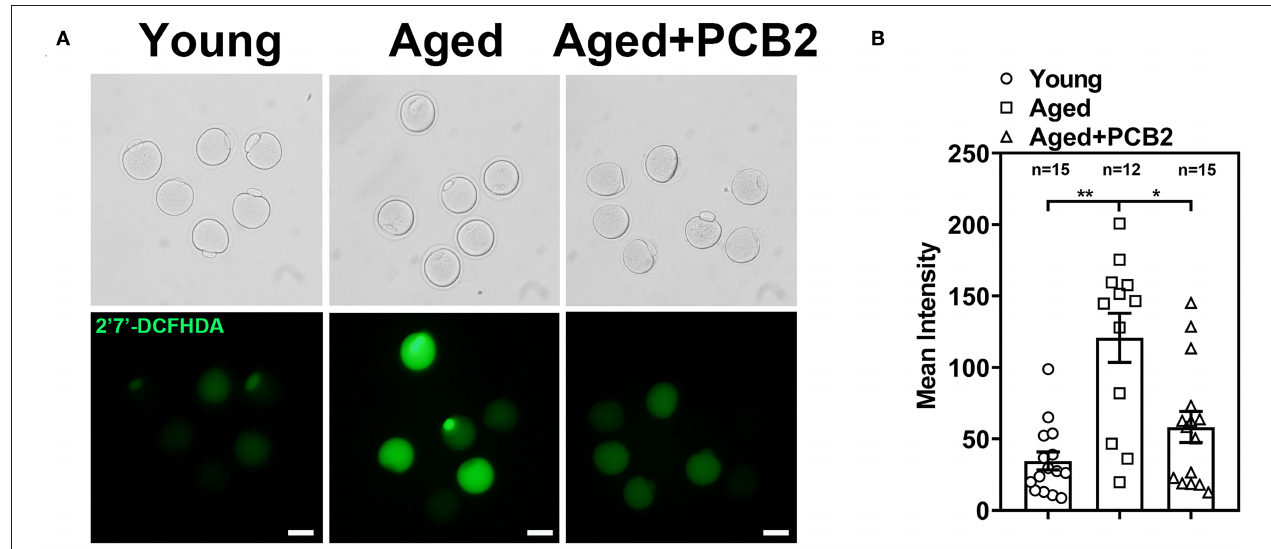
FIGURE 5 | Effect of PCB2 supplementation on oxidative stress levels in aged oocytes. (A) Representative images of ROS levels in different groups. Scale bar, 50 µ m. (B) Quantification of ROS fluorescence intensity was recorded in different groups. Data are presented as mean percentage (mean ± SEM) of at least three independent experiments. * P < 0.05, ** P <